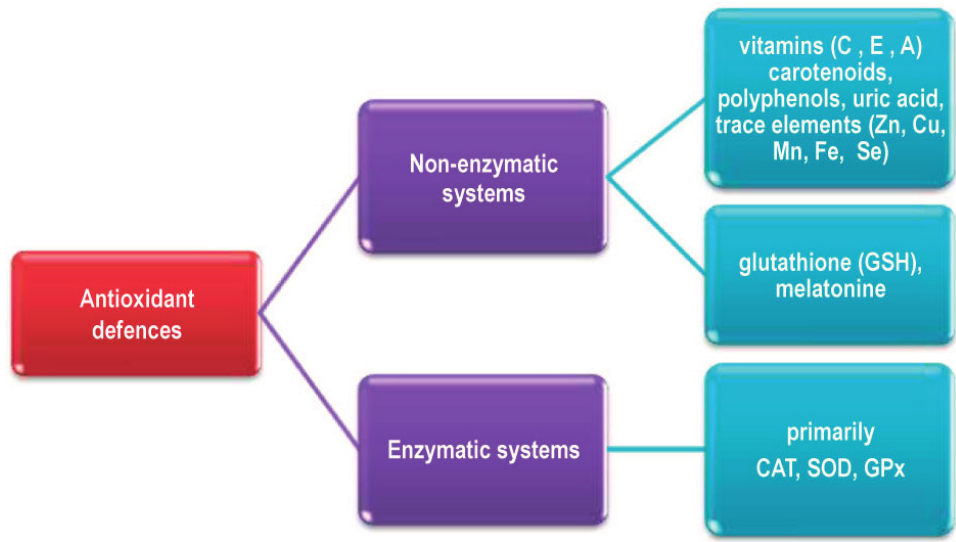
Figure 4. Major ROS defense mechanisms in the